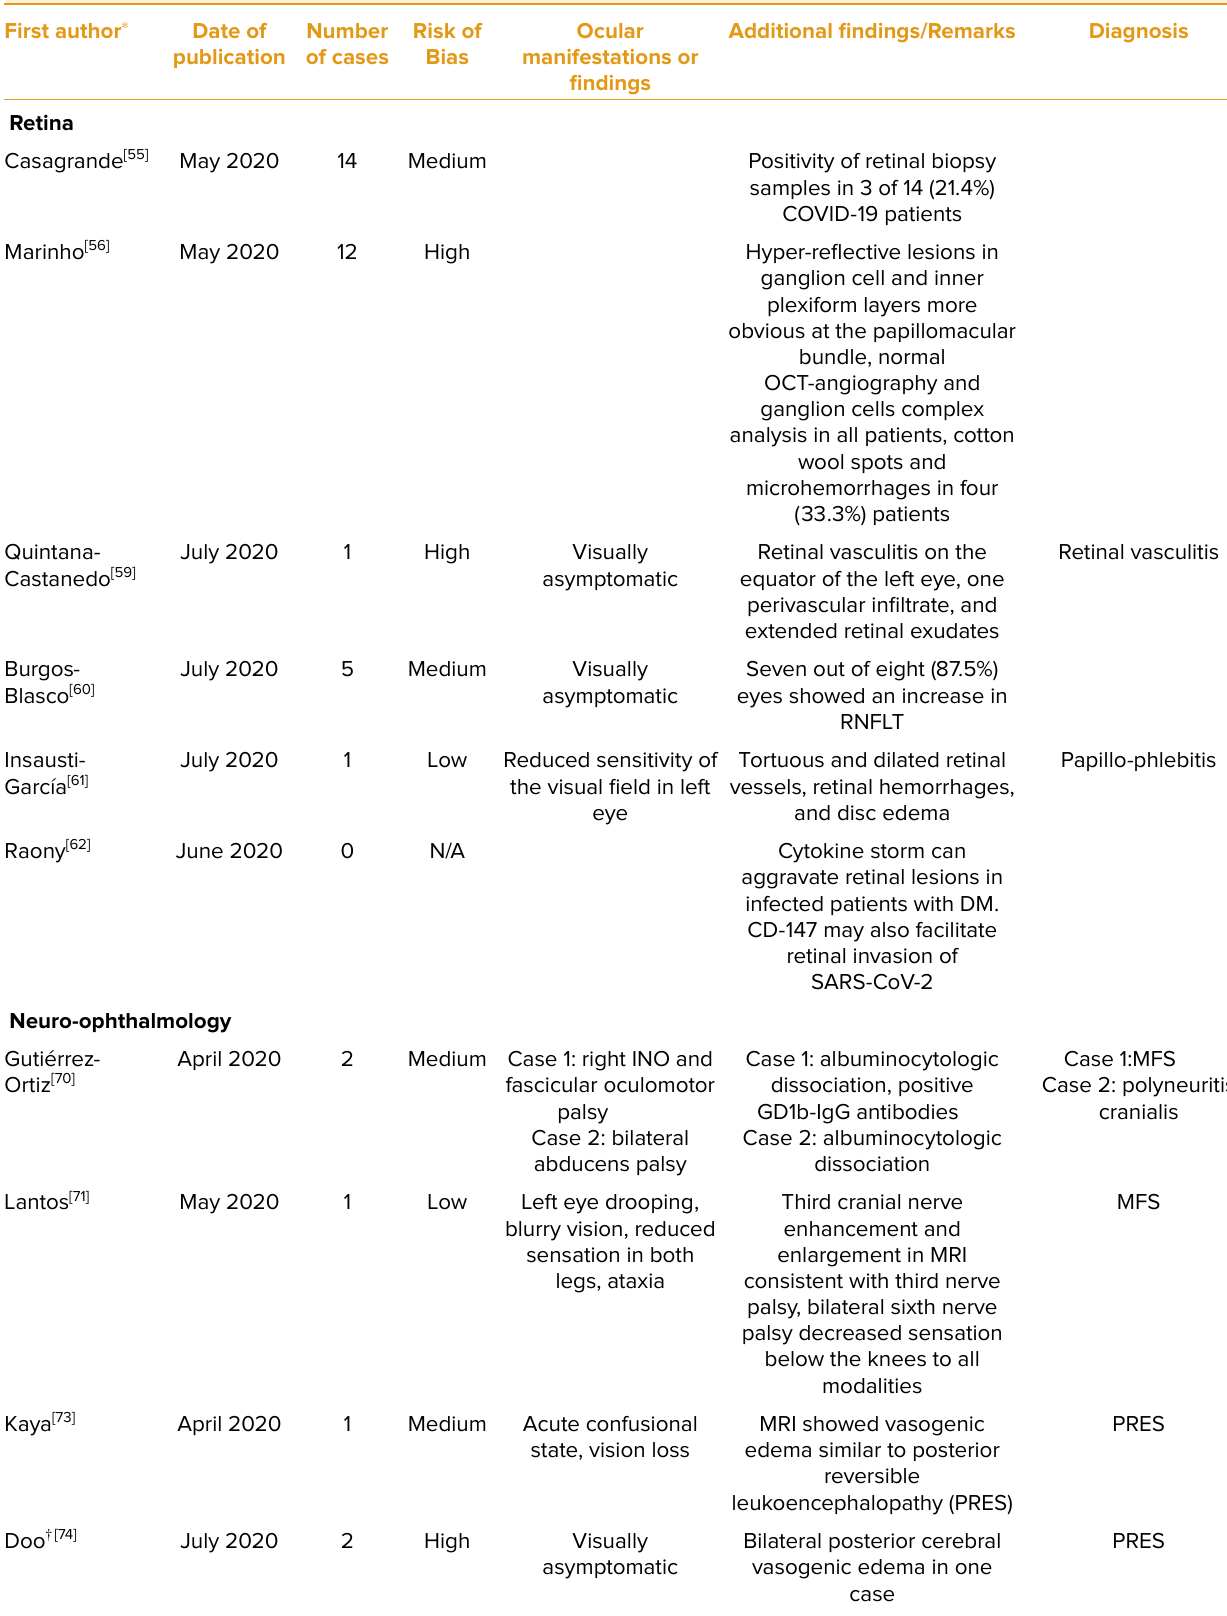
Table 2. Characteristics and main findings of the included studies (retina, neuro–ophthalmology, thromboembolic, and postmortem